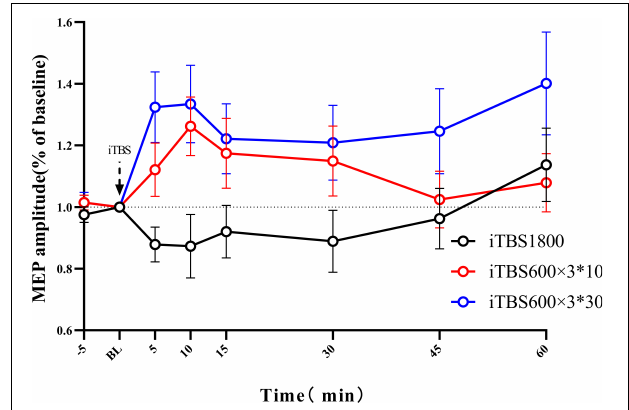
FIGURE 3 | The after-effect of 1800 pulses iTBS on MEP amplitude at times 5, 10, 15, 30, 45, and 60 min following three different iTBS condition. MEPs amplitude were normalized to